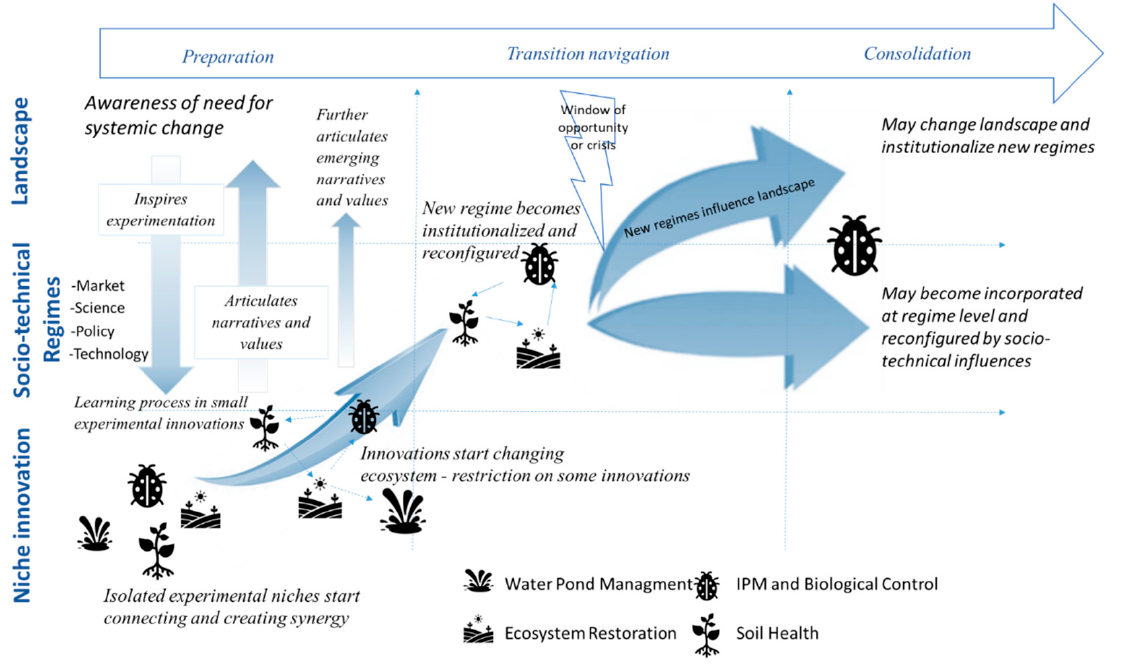
Figure 2. Authors’ elaboration based on multi-level concepts offered by Geels, F.W. [36], and niche synergy offered by Pereira L.M. [58].